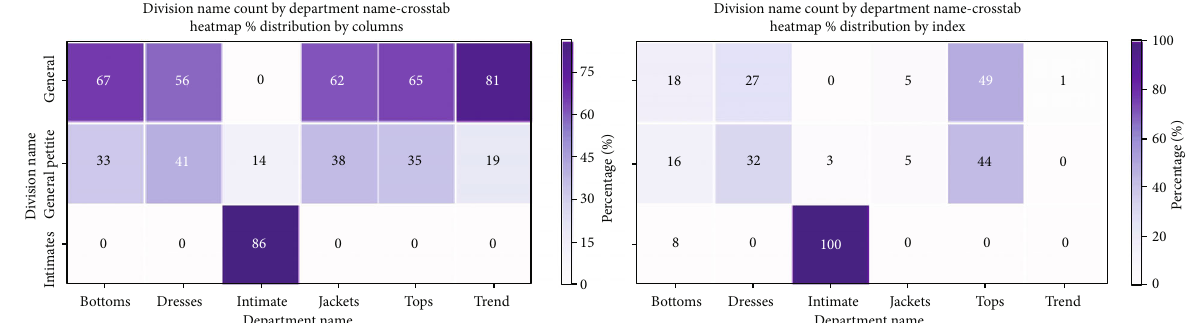
Figure 8: Standardized cross-tabulation of clothing by department and division.